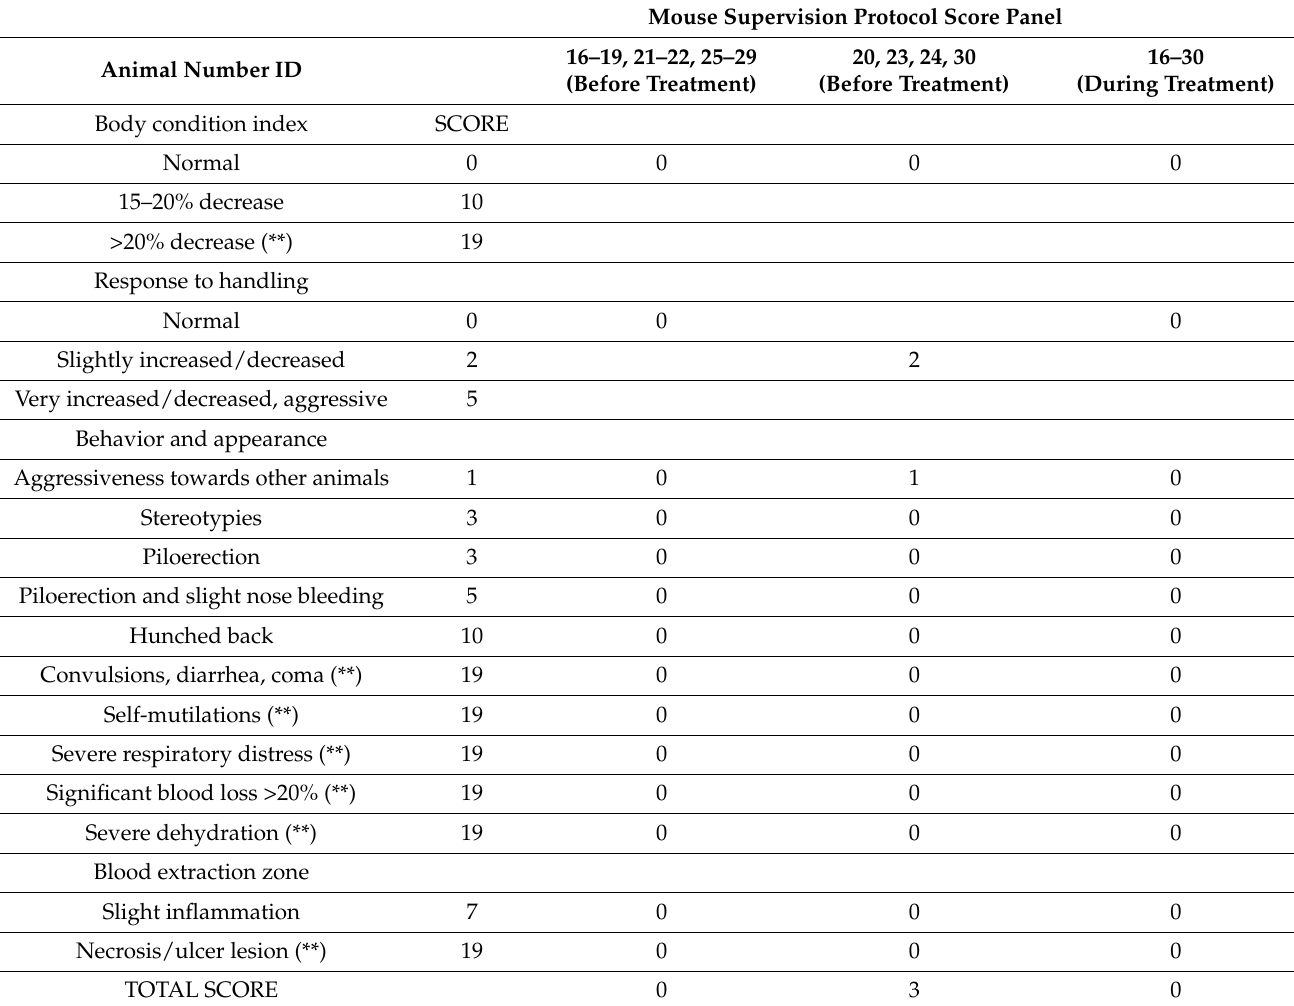
Mouse Supervision Protocol Score